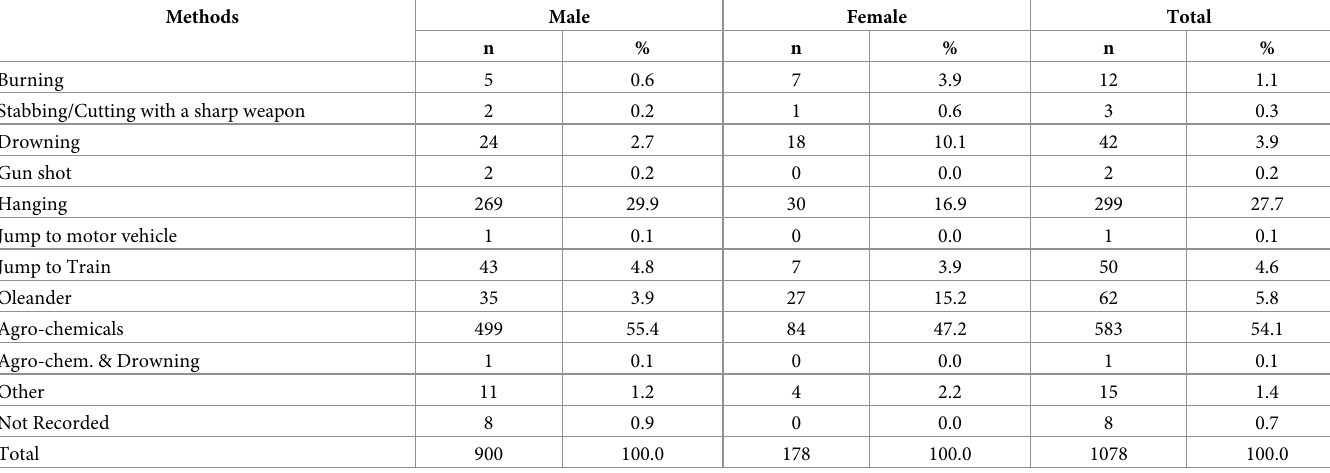
Table 5. Suicides reported to police stations in KD by method and